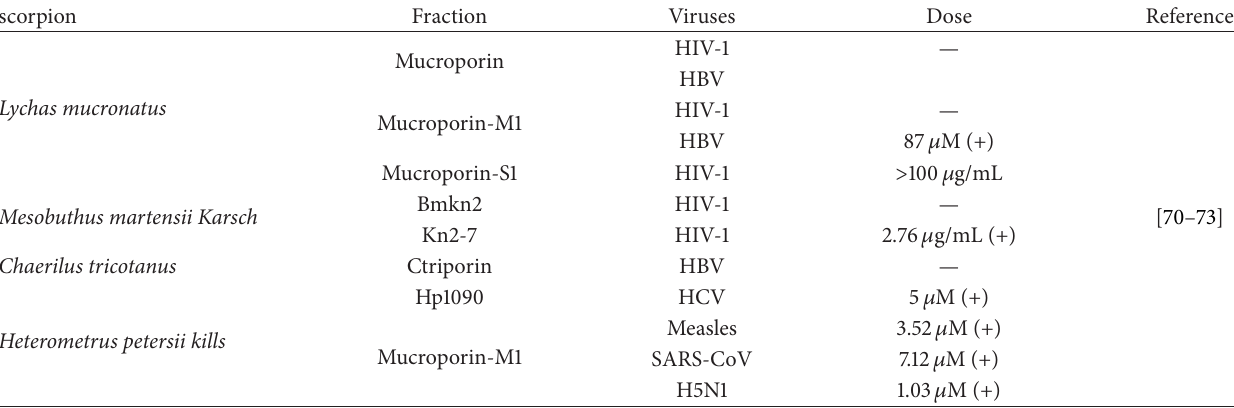
Table 3: List of chosen antiviral peptides originating from scorpions.